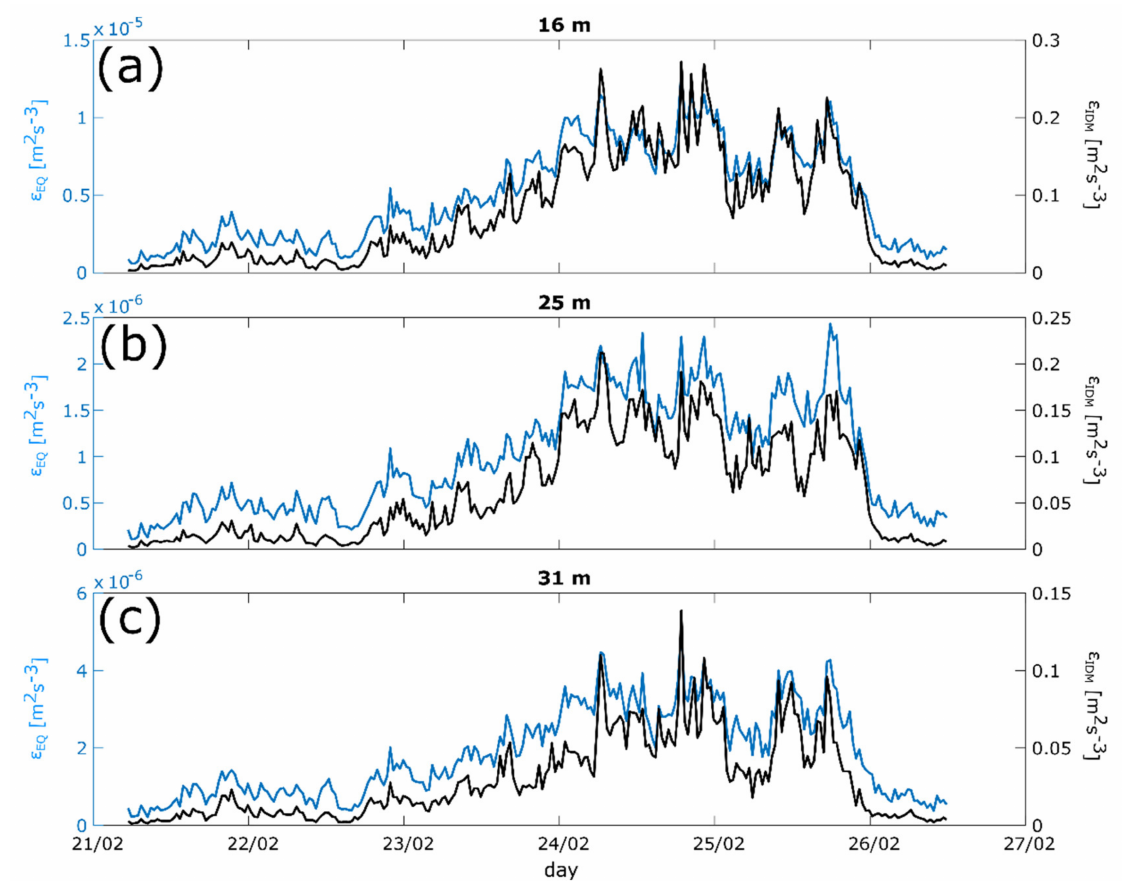
Figure 3. Time series of viscous dissipation, VD, obtained directly from prognostic equation for turbulence variances (left, light curve) and VD obtained by IDM method (right, black) for the longest bora episode threat ( a ) 16 m, ( b ) 25 m and ( c ) 31 m mid − levels. The square of the correlation coefficients are r 2 = 0.97 at 16 and 25 m and r 2 = 0.95 at 31 m mid −